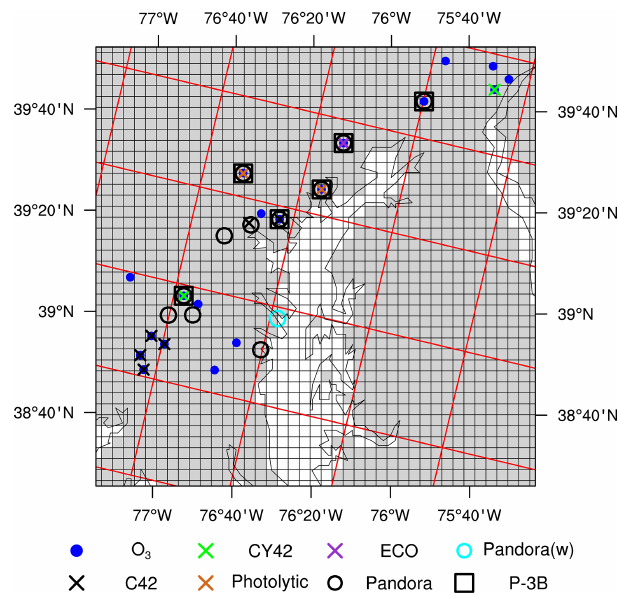
Figure 1. The locations of surface and P-3B aircraft observations during the DISCOVER-AQ 2011 campaign. We mark the 36km REAM grid cells with red lines and the 4km REAM grid cells with black lines. Gray shading denotes land surface in the nested 4km WRF domain, while the white area denotes ocean or water surface. Blue dots denote surface O 3 observation sites. Cross marks denote surface NO 2 observation sites, and their colors denote differ- ent measurement instruments: green for the Thermo Electron 42C- Y NO y analyzer, dark orchid for the Ecotech Model 9841/9843 T- NO y analyzers, black for the Thermo Model 42C NO x analyzer, and chocolate for the Teledyne API model 200eup photolytic NO x analyzer. Circles denote Pandora sites, and the cyan circle denotes a Pandora site (USNA) on a ship. Black squares denote the inland P-3B aircraft spiral